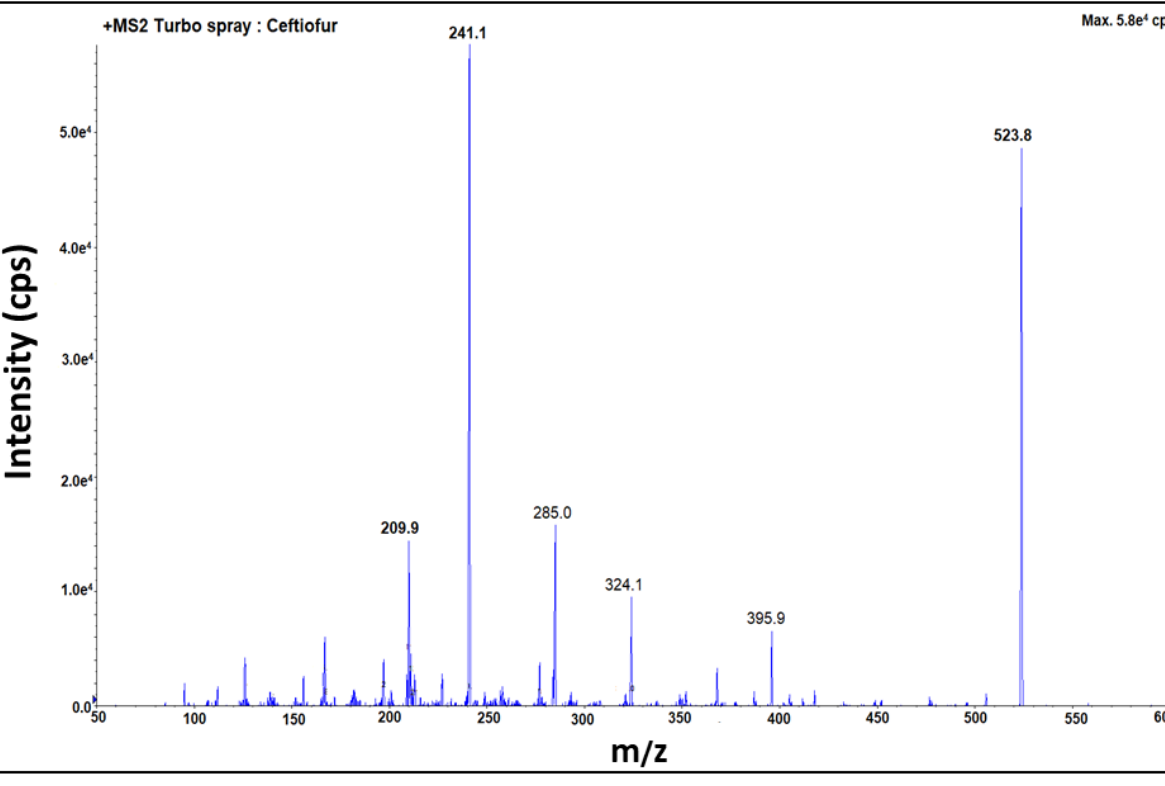
Figure 5. Fragmentation pattern of Ceftiofur.